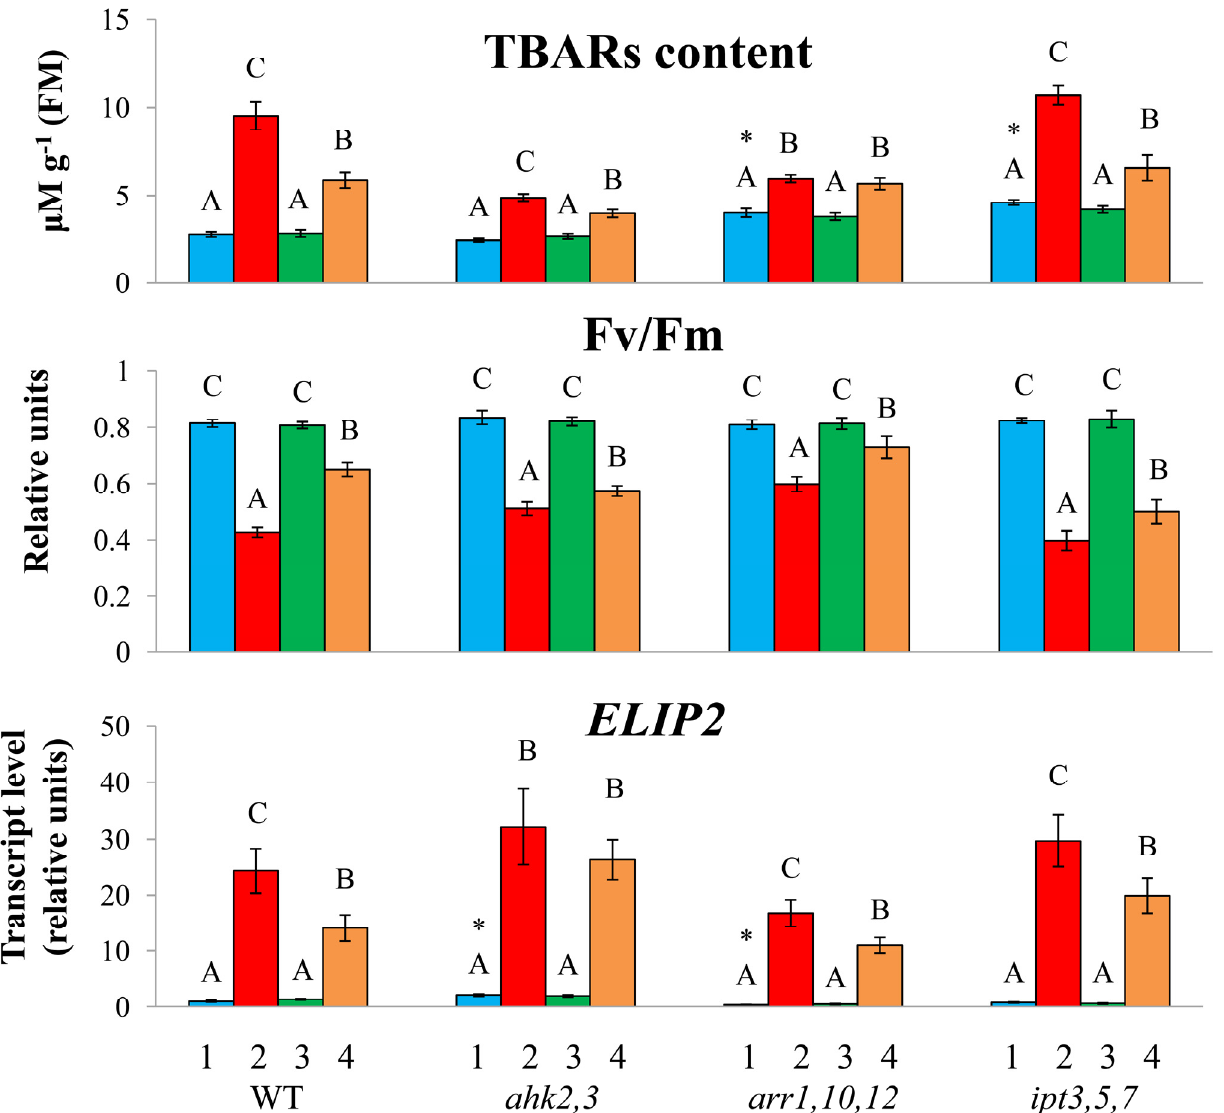
Figure 1. Effect of HL stress and melatonin treatment on the TBARs content, Fv/Fm parameter and expression of the ELIP2 gene. The data presented in the figure are the mean values ( n ≥ 3). The error bars represent SEs. Different letters denote statistically significant differences among variants within the same genotype at p < 0.05 (ANOVA with post hoc Tukey’s multiple-comparison test). Asterisks indicate statistically significant differences between the mutants and the wild-type under the corresponding type of treatment at p < 0.05 ( t